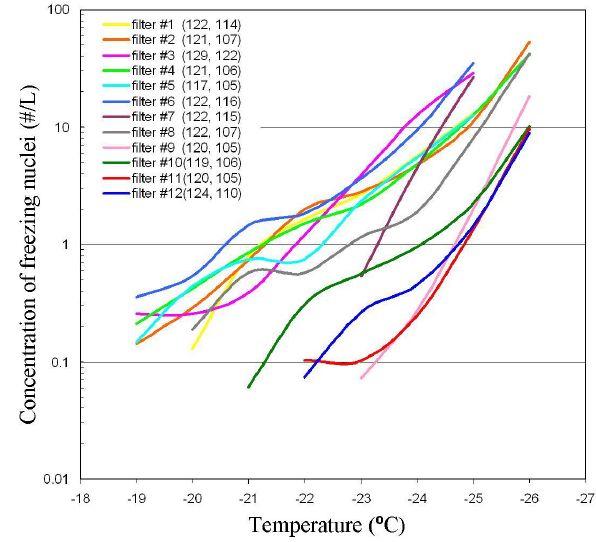
Fig. 4: Concentration of Freezing Nuclei in the air for the different samples calculated from Eq. 1. The first number in the parenthesis represents the number of drops used in the experiment and the second is the one used for the present calculations after deducting the drops that froze on the blank filters (see text for explanation).